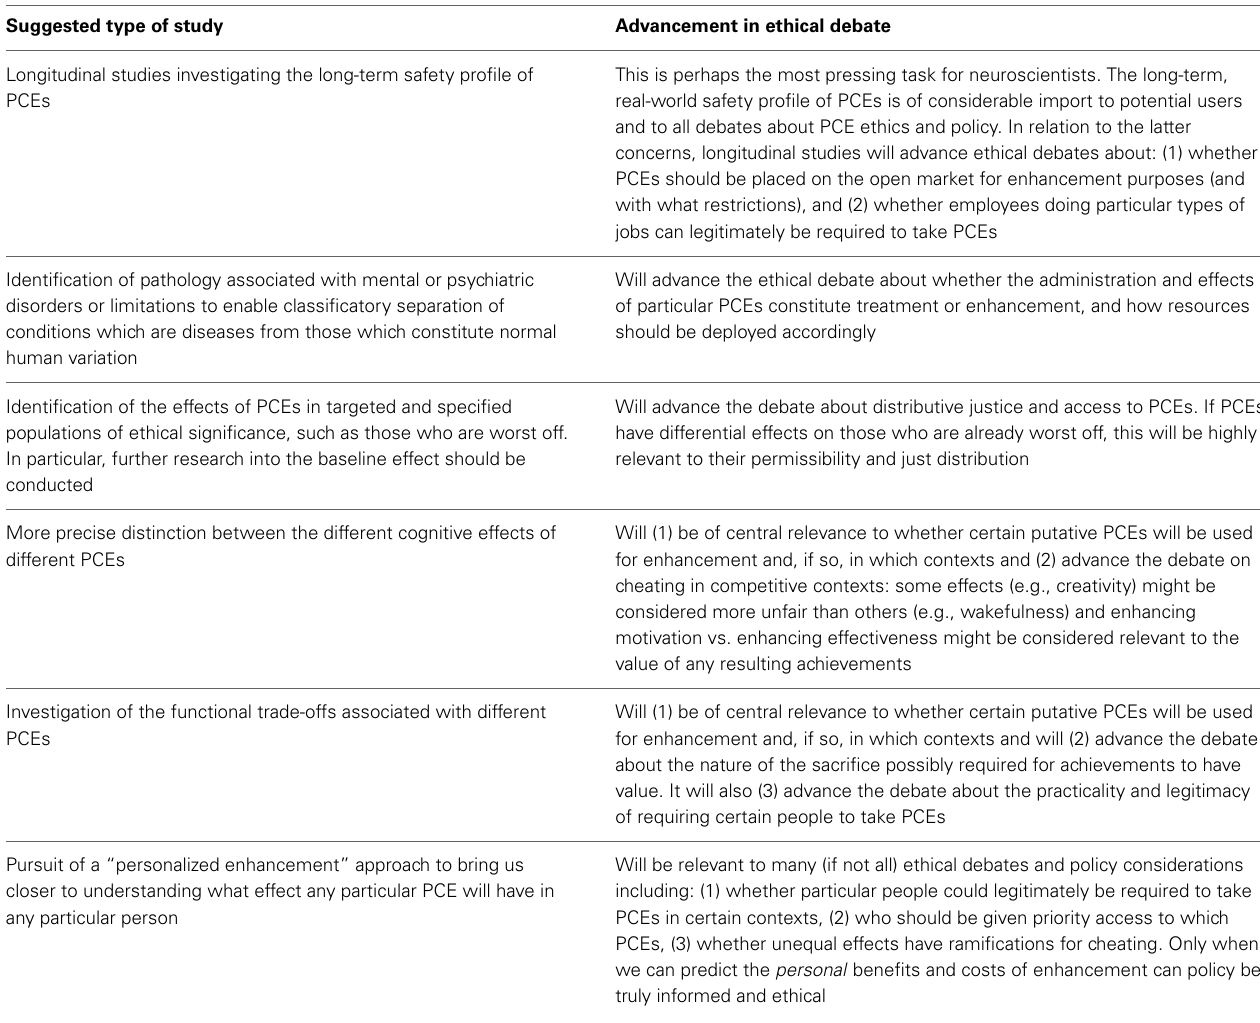
Table 1 | Summary of ethical agenda for neuroscientific research. Suggested type of